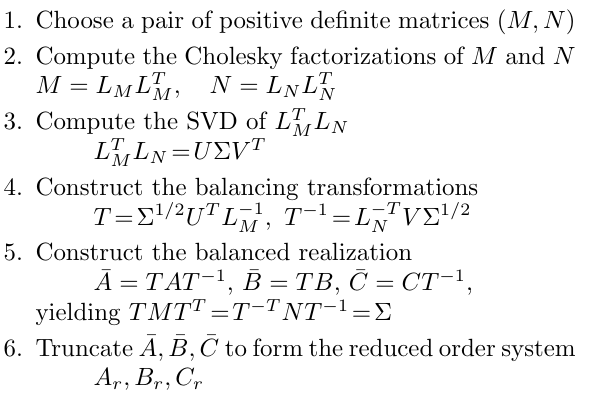
Table 1: Balanced Truncation